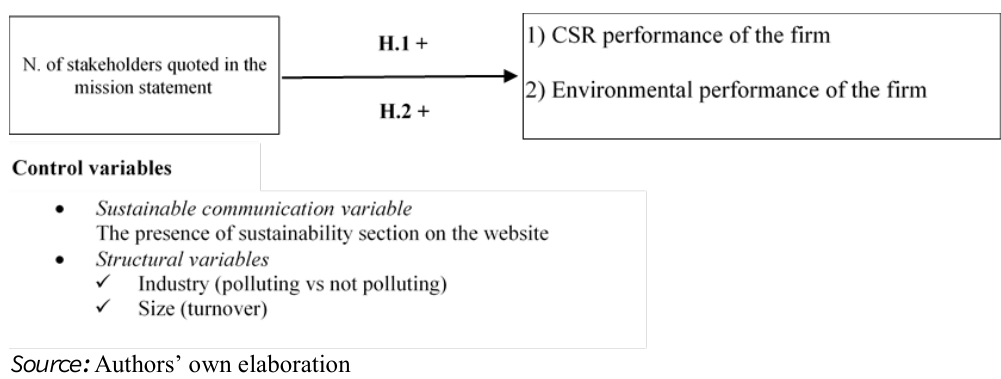
Figure 1: Conceptual Framework and Hypotheses’